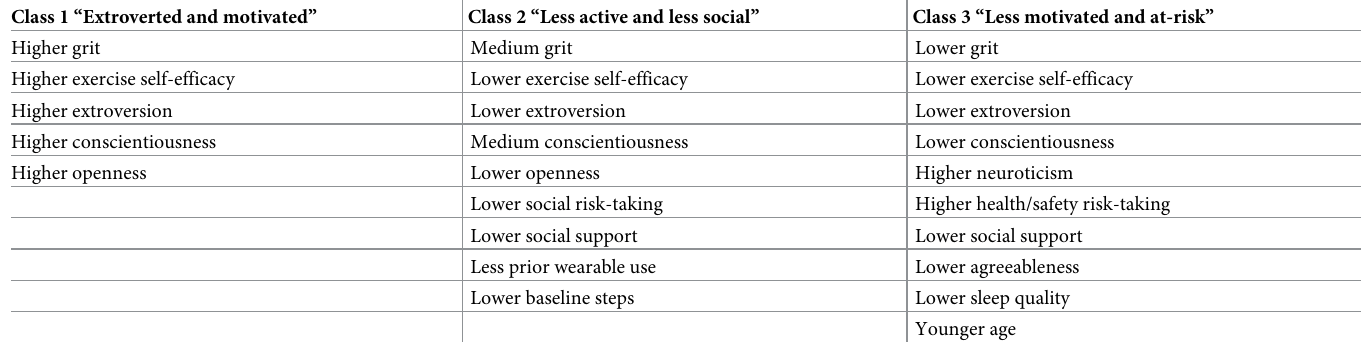
Table 2. Key factors driving class segmentation.